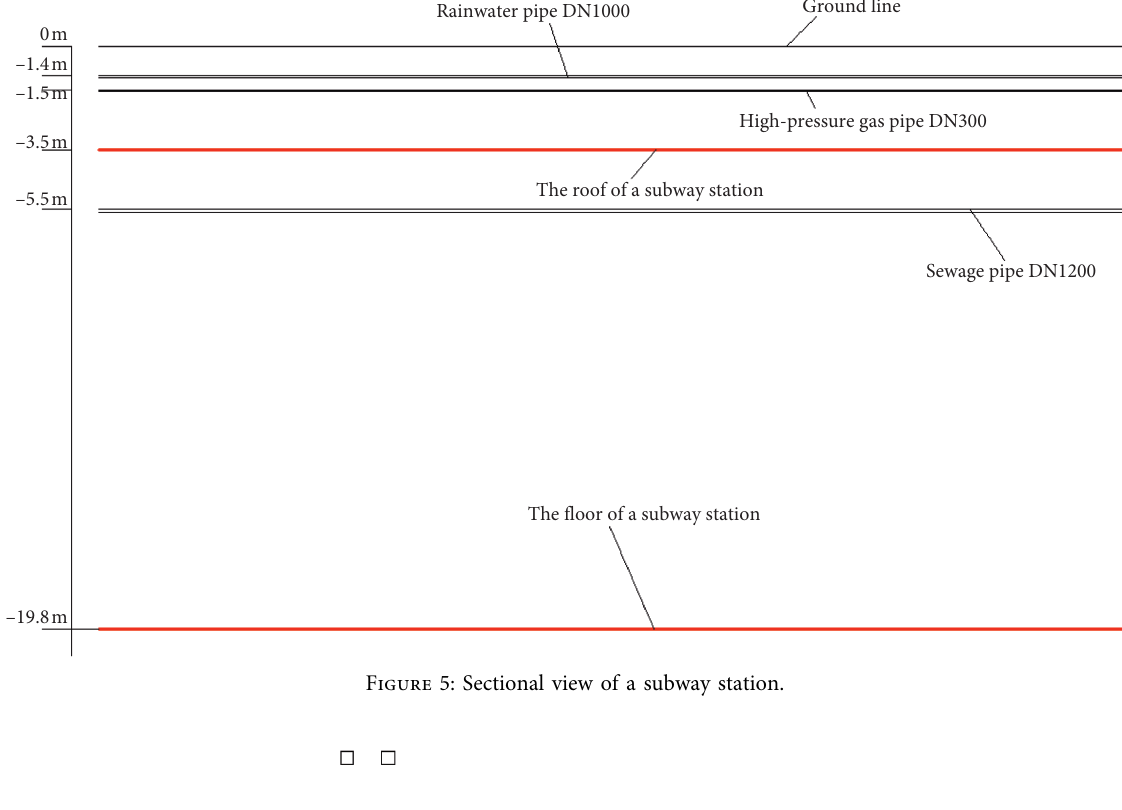
Figure 5: Sectional view of a subway station.